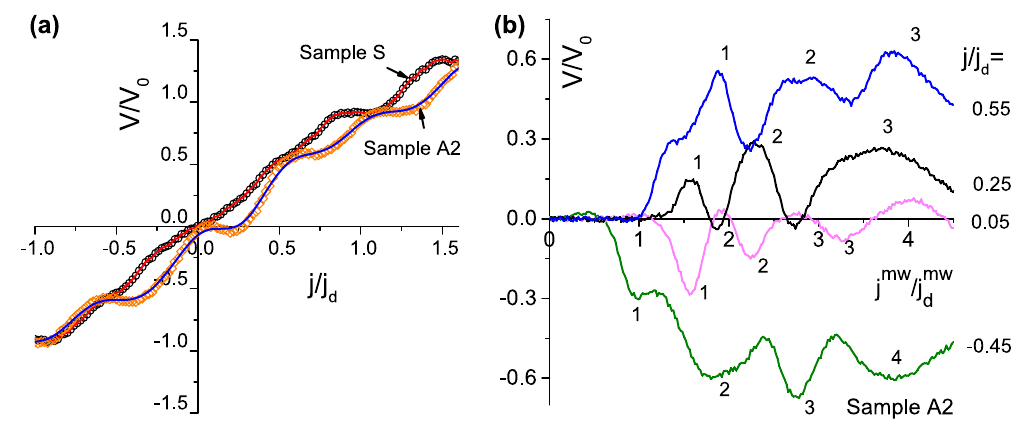
Figure 5. ( a ) Shapiro steps in the CVC of microstrips S and A2 at = . j j / 1 83 mw dmw , T = 0.98 T c , and the fundamental matching field H m = 7.2 mT. Symbols: Experiment. Solid lines: Fits to Eq. (6). (b) Mode-locking “fringes” in the dc voltage with increasing mw amplitude at T = 0.98 T c , H m = 7.2 mT, and a series of dc densities as